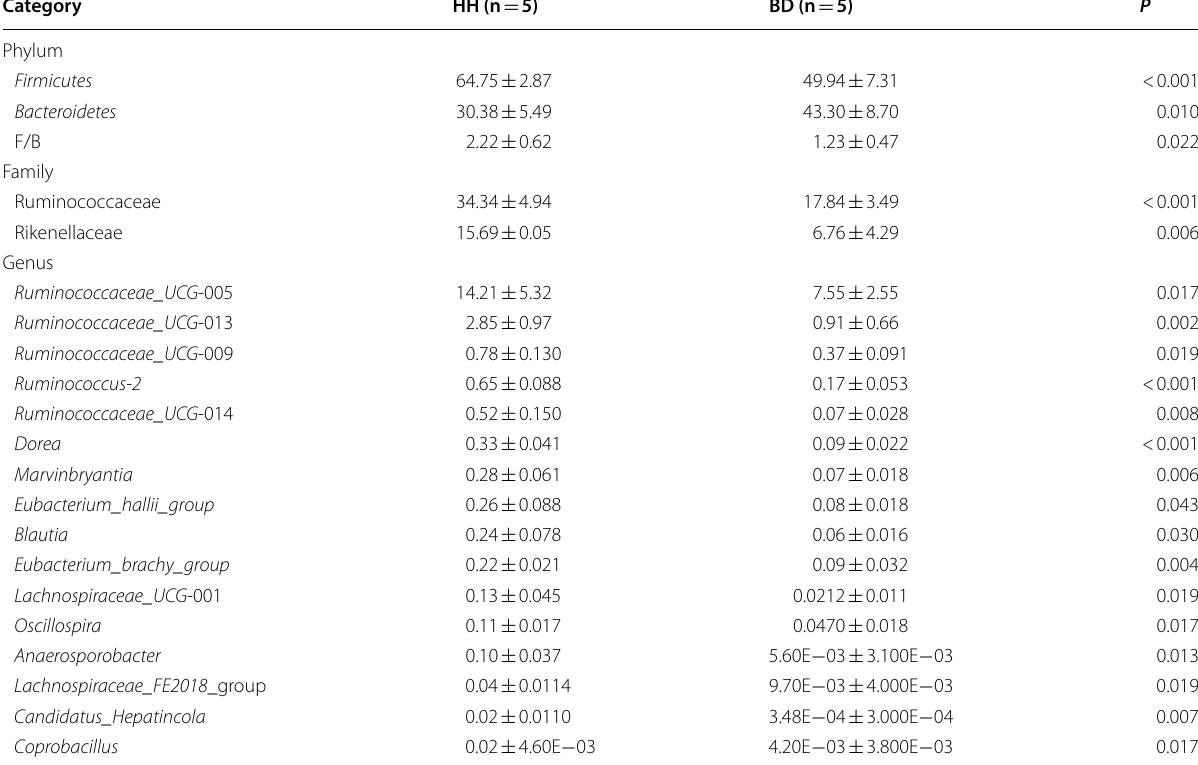
We only list some of the genera BD brisket disease, HH healthy heifer, F/B